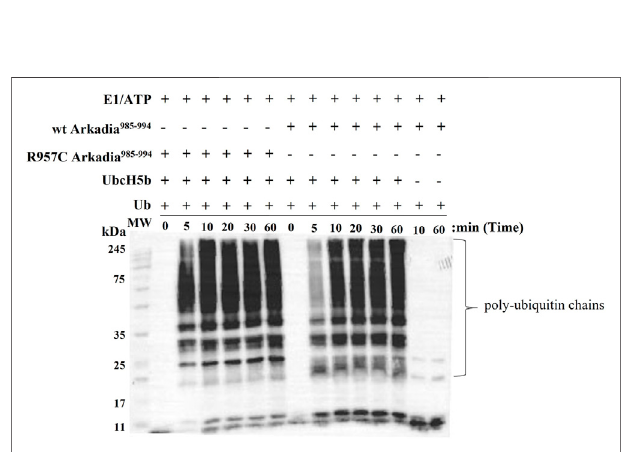
FIGURE 7 | Western blot of in vitro ubiquitination assays of R957C Arkadia 985 – 994 (left) and wt Arkadia 985 – 994 (right).